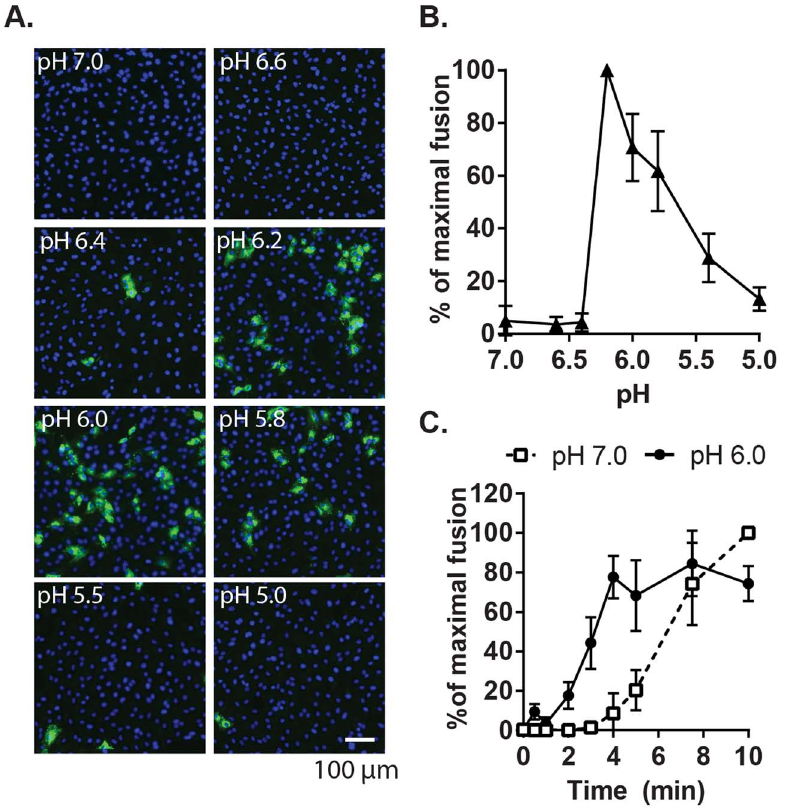
Figure 2. Characterization of the pH threshold for RuV fusion. (A) Fusion-infection assay. Virus was pre-bound to Vero cells as in Fig. 1A. Cells were washed and incubated for 3 min at 37 u C in calcium-containing medium at the indicated pH, and then cultured 48 h at 37 u C in growth medium plus 20 mM NH 4 Cl to prevent secondary infection. Infected cells were detected by immunofluorescence (green), and nuclei were counterstained with Hoescht (blue). (B) Quantitation of (A). Data were normalized to maximal fusion, which was observed at pH 6.2 in each experiment. Graph shows the mean and standard deviation of 4 independent experiments. (C) Kinetics of RuV fusion. A fusion infection assay was performed as in (A), using calcium-containing buffers at either pH 7.0 or pH 6.0 and treating for the indicated time at 37 u C, followed by addition of growth medium containing 20 mM NH 4 Cl and culture for 48 h. Graph shows the mean and standard deviation of 3 independent experiments.